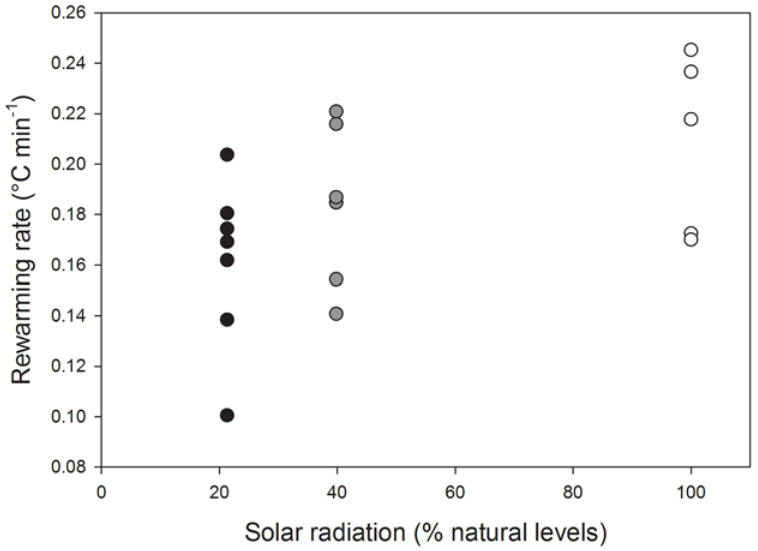
Fig 2. Rewarming rate during arousal. Eastern rock elephant shrews ( Elephantulus myurus ) housed in outdoor cages with exposure to natural (100%) or experimentally reduced (approximately 20% or 40%) levels of solar radiation. Each data point represents one